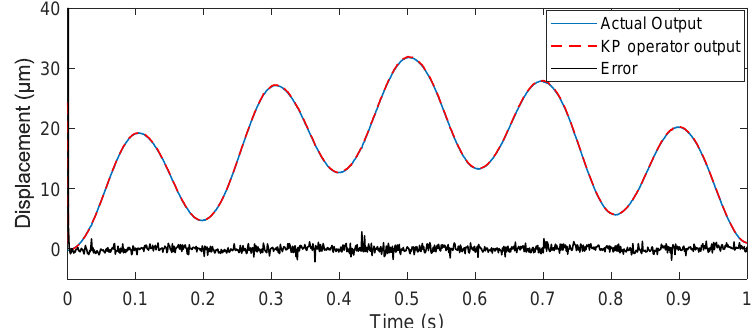
Figure 7. Experimental result of KP operator based on the gradient descent algorithm under the complex wave